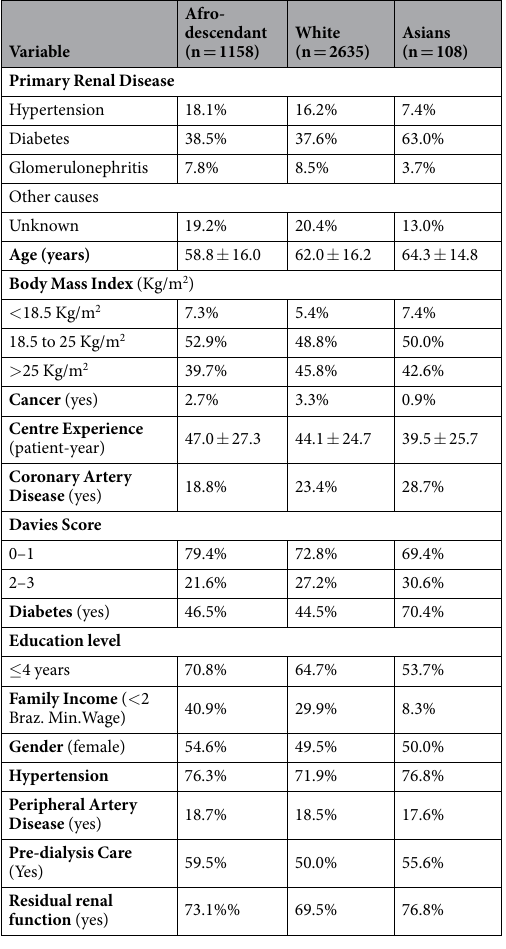
Table 1. Clinical and demographic characteristics according to race. Differences between groups were not statistically significant only for peripheral artery